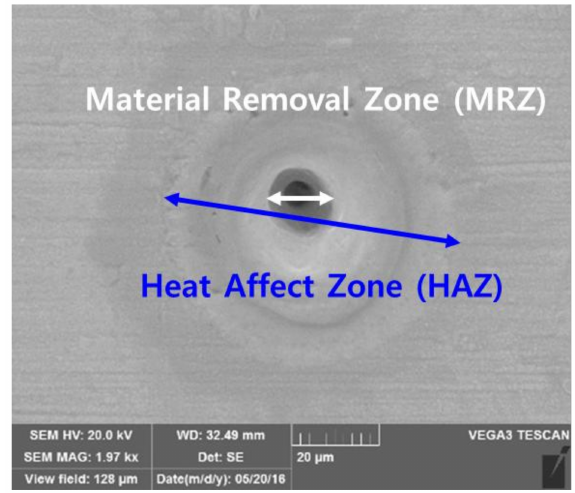
Figure 2. The scanning electron microscope (SEM) image describing measurement of the heat affect zone (HAZ) and material removal zone